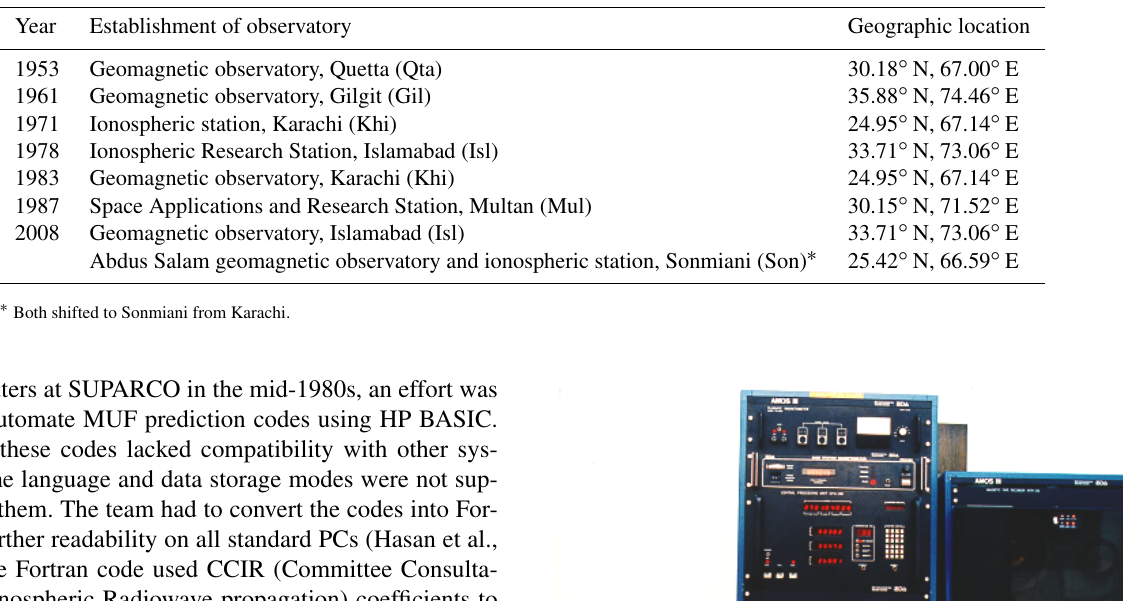
Table 1. Time series expansion of ionospheric and geomagnetic observatories in Pakistan.